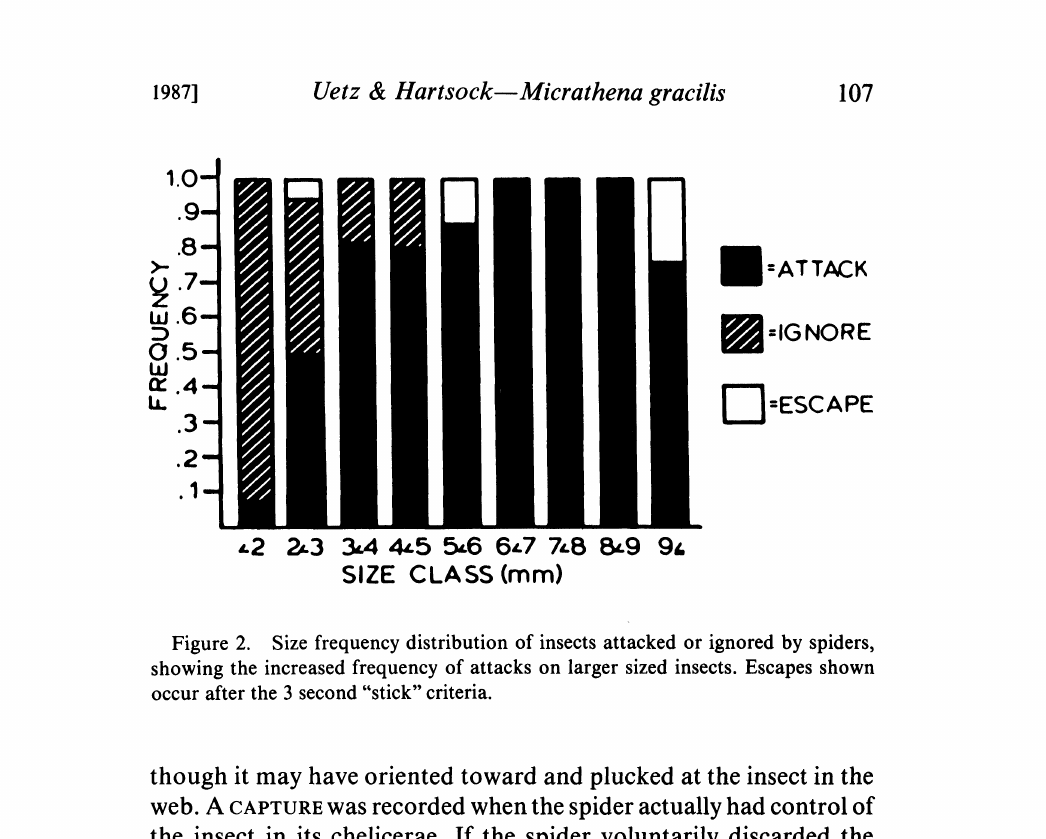
Figure 2. Size frequency distribution of insects attacked or ignored by spiders, showing the increased frequency of attacks on larger sized insects. Escapes shown occur after the 3 second "stick"